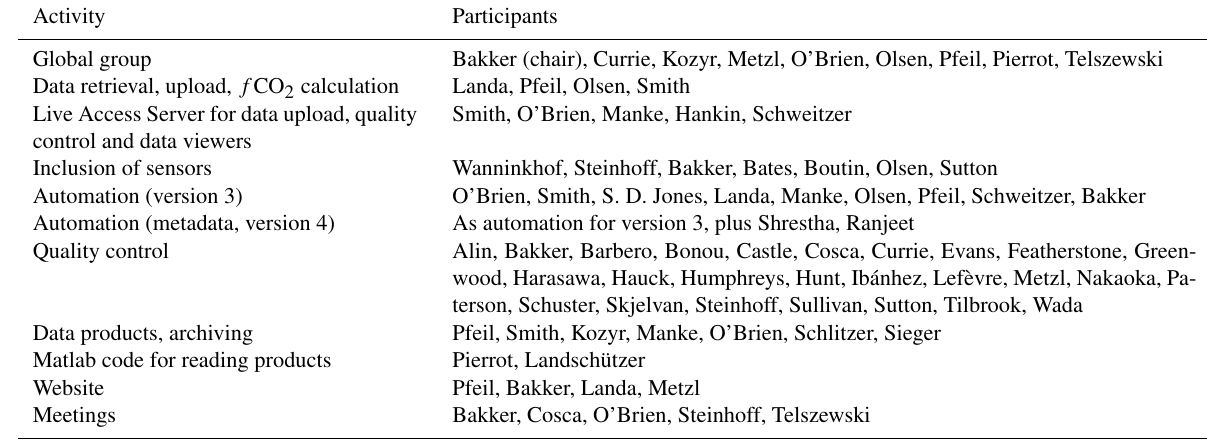
Table 3. Activities and participants in SOCAT version 3 and the automation (after Bakker et al., 2014). Regional group leads are in Table 4. Activity